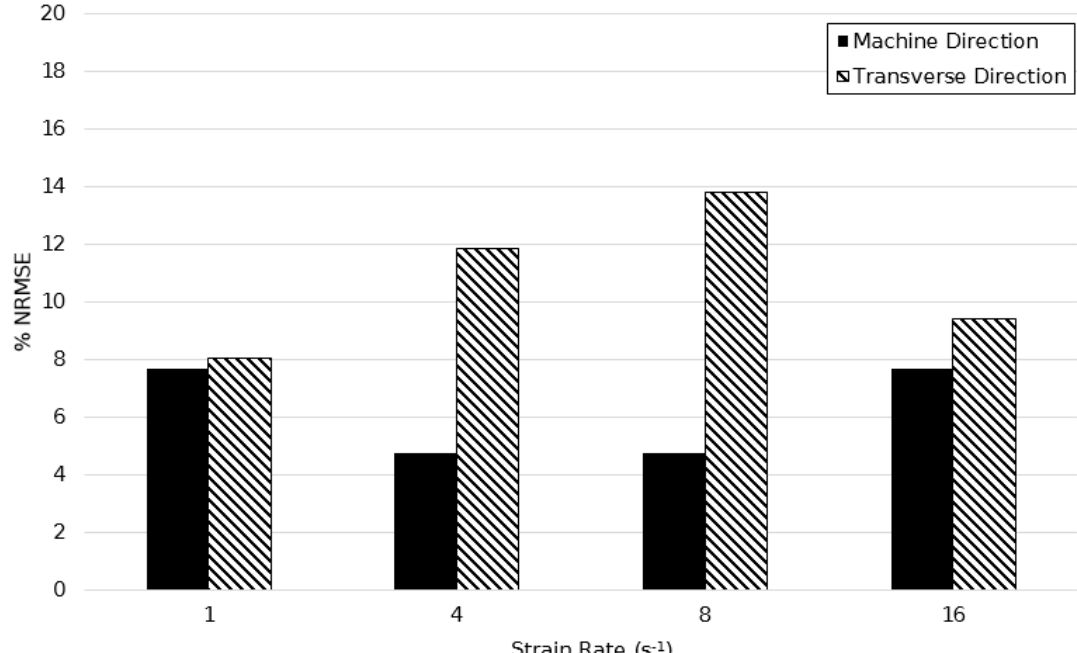
Figure 26. Normalised root mean squared error between simulated and experimentally observed stress–strain behaviour between strain rates of 1–16 s − 1 at a temperature of 150 °C.